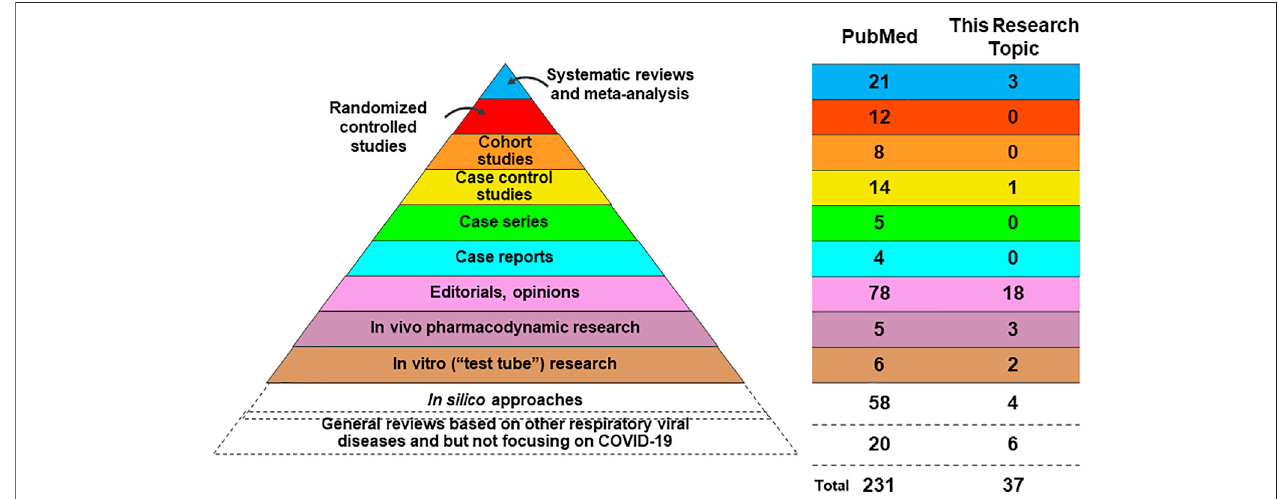
FIGURE 2 | Publication on TM associated with